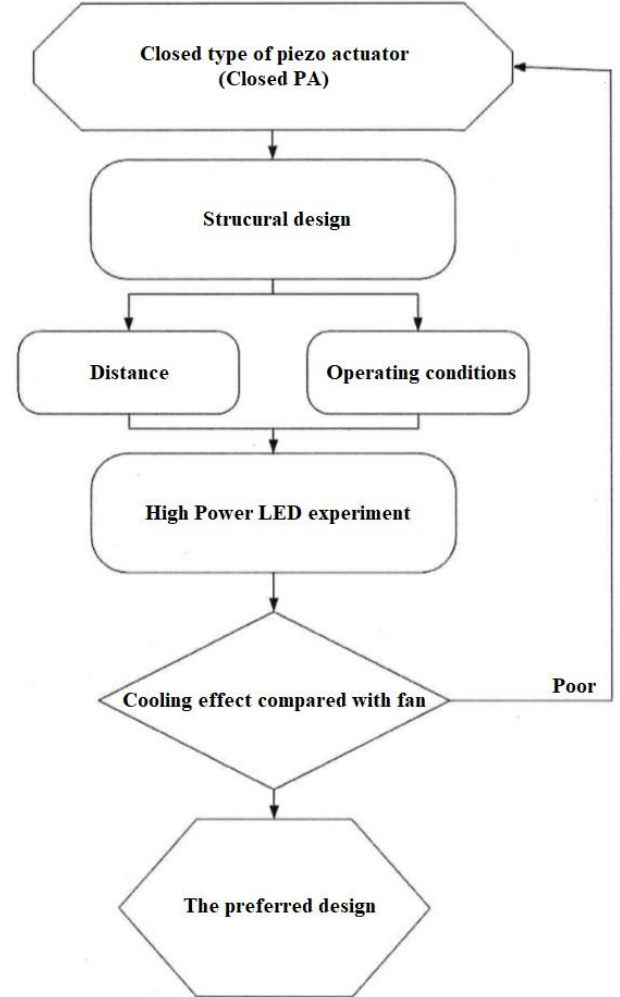
Figure 2. Experimental flow chart.